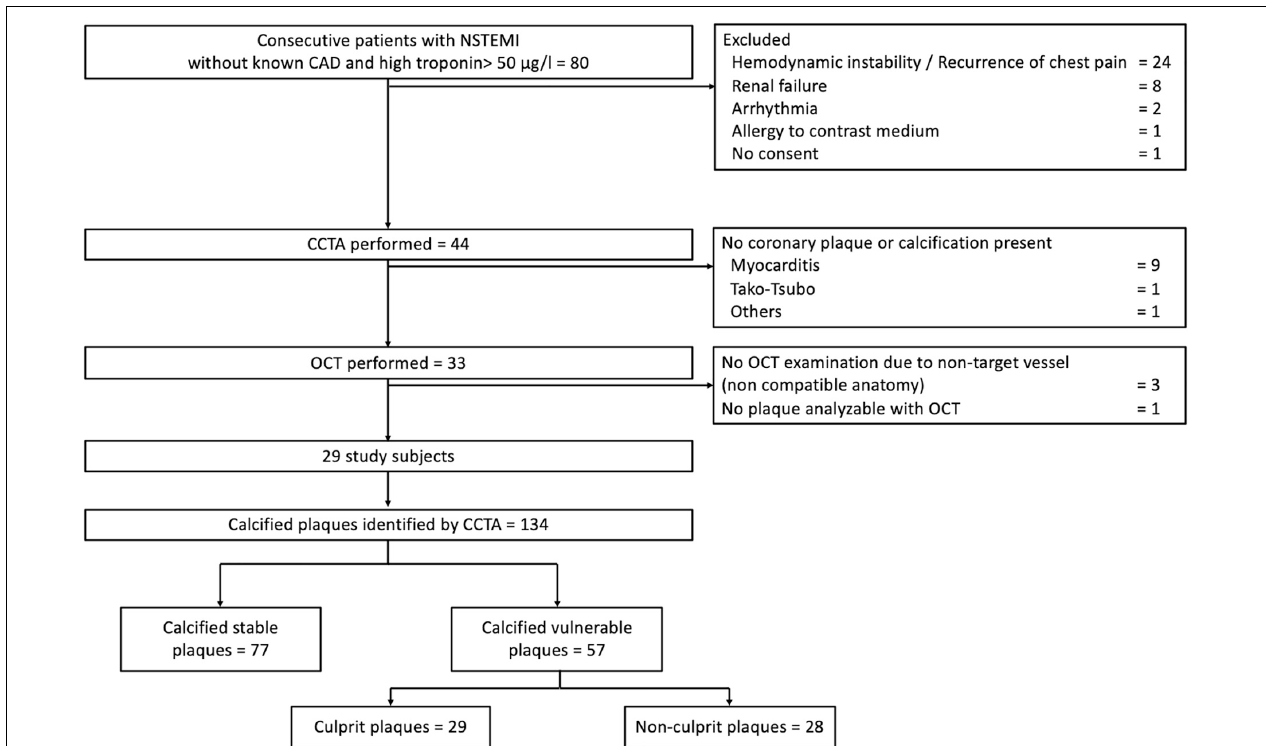
FIGURE 2 | Study flowchart. Abbreviations: ACS, acute coronary syndrome; CAD, coronary artery disease; CCTA, coronary computed tomographic angiography; FCT, fibrous cap thickness; NSTEMI, non–ST-segment elevation myocardial infarction; OCT, optical coherence